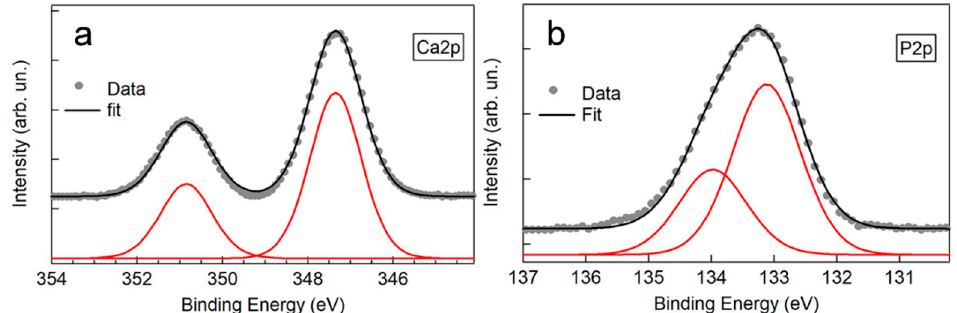
Figure 3. Representative XPS high-resolution spectra of ( a ) Ca2p and ( b ) P2p core regions of anodized niobium.